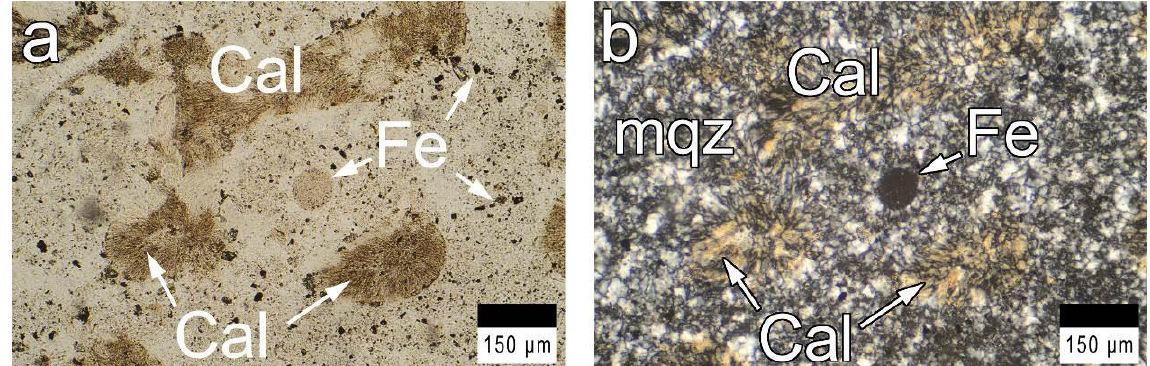
Figure 14. a) & b) Microphotos (polarized light) of a typical chert artefact from Piatra Tomii. Well-developed microcrystalline quartz mixed with calcite; Small clusters of fibrous microquartz and Fe compounds restricted to small areas are seen. Left side, one polarizer (1P). Right side, the same with crossed polarizers (+P). Abbreviations: mqz for microgranular quartz, Cal for calcite, Fe for iron compounds.